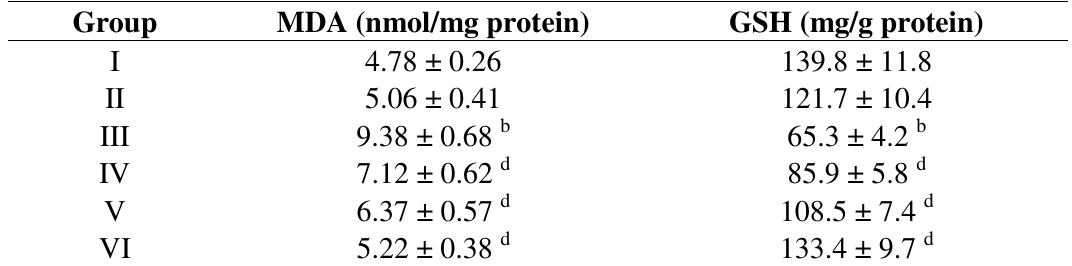
Table 5. Effect of GBE50 on myocardium MDA and GSH levels in